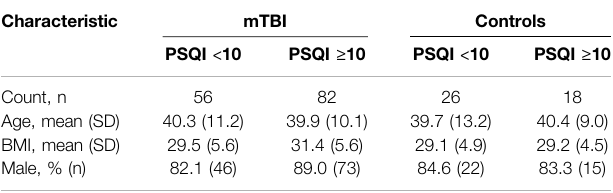
TABLE 1 | Population demographics according to presence/absence of mTBI history and clinically signi fi cant sleep complaints. PSQI score greater than or equal to 10 was considered clinically signi fi cant according to accepted guidelines for military populations. Characteristic